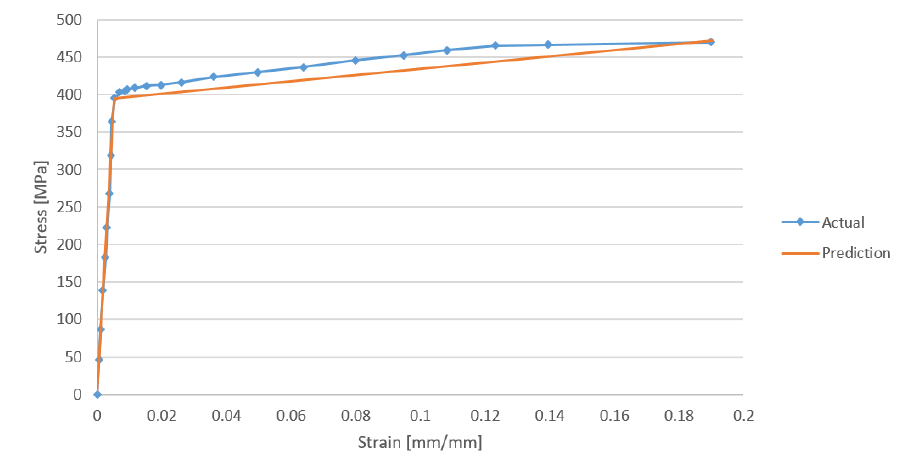
Figure 18. Actual stress-strain curve and its bilinear predicted approximation for Al 2024-T4 (actual curve from Reference